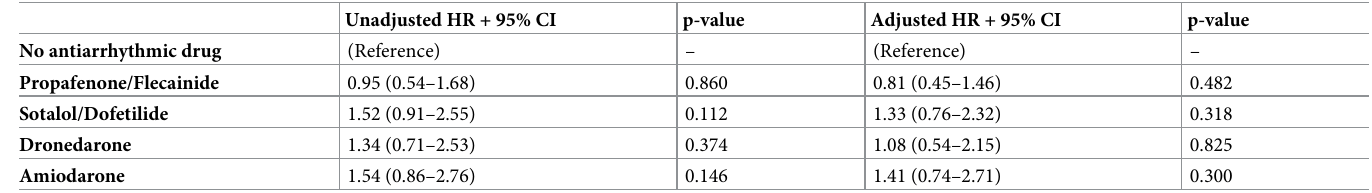
Table 5. Unadjusted and adjusted Cox proportional hazard ratios and 95% confidence intervals for: Second ablation procedure (No AAD is reference